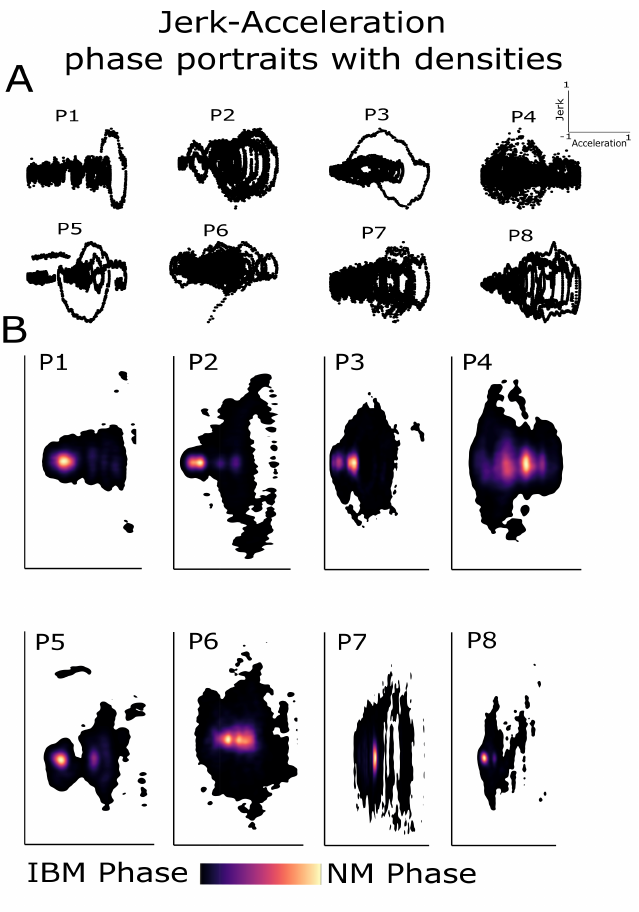
Figure 3. Jerk acceleration phase portraits with densities. On the top right side of the figure, the coordinates showing the x-axis and y-axis displayed (cid:126) a and (cid:126) j normalized values. ( A ) The top eight panels display phase portraits for all the participants. Thus, each panel shows a phase portrait of a participant. The phase portrait indicates rhythmicity of varying magnitudes (amplitudes) during the IBM phase. ( B ) The bottom eight panels show the density of data points in the phase portraits. Thus, each panel displays the density plot of a participant. The NM phase and IBM phase isolation are visible. The x ( (cid:126) a ) and y ( (cid:126) j ) axes values are normalized between ( − 1,1) across participants for better visual representation. A spectrum of densities (bottom) can be observed during the IBM phase, which is associated with different sub-phases during SP. Overall, these figures show the phasic nature of contractions during the